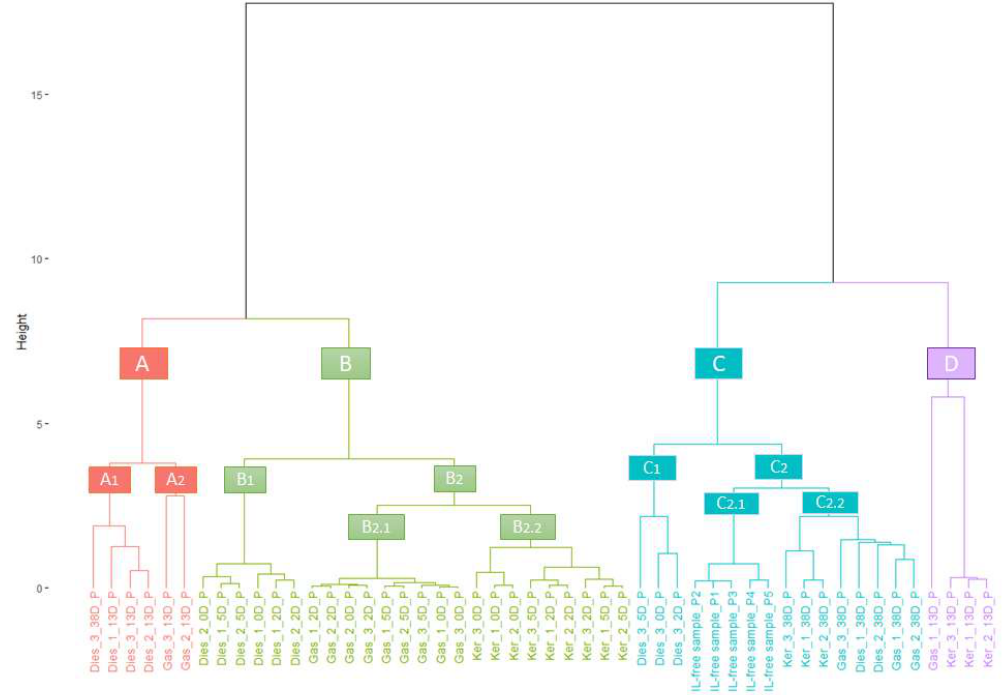
Figure 1. Dendrogram resulting from the analysis (M 50×990 ).